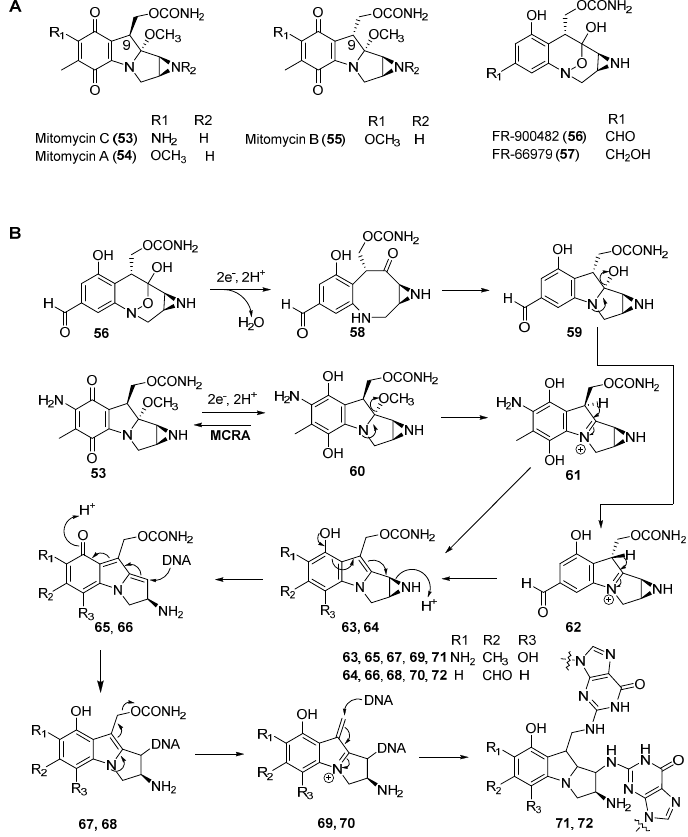
Figure 10. ( A ) Chemical structures of mitomycins. ( B ) Proposed mechanism of DNA cross-linking by mitomycin C and FR-900482.